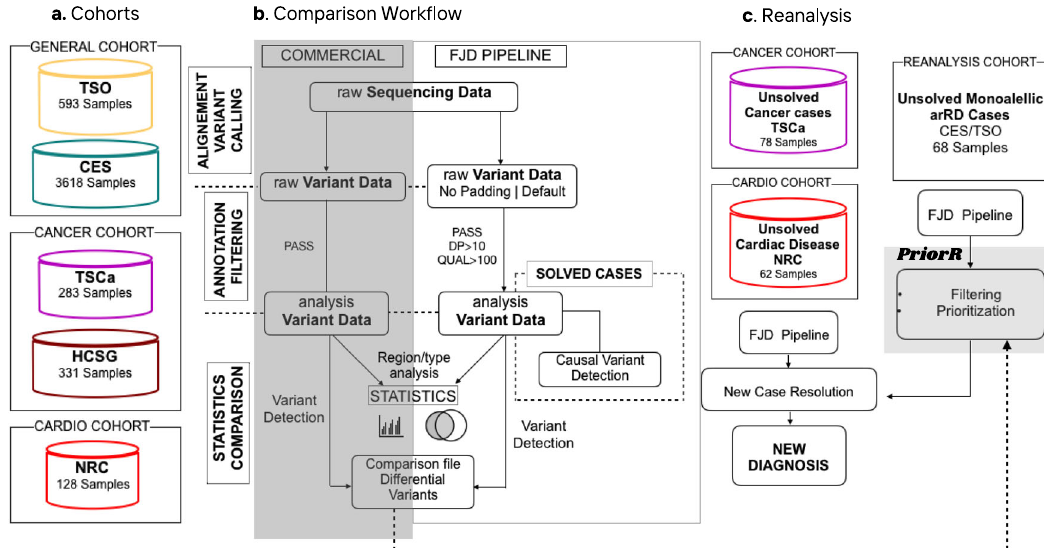
Fig. 1 General framework of this study. a The different subcohorts used: the heterogeneous cohort of genetic diseases (TSO and CES), the hereditary cancer cohort (TSCa and HCS), and the cardiovascular disease cohort (NRC). b Work fl ow followed to compare the performance of the commercial pipeline and the FJD-pipeline. c Steps followed in the systematic reanalysis of negative (unsolved)